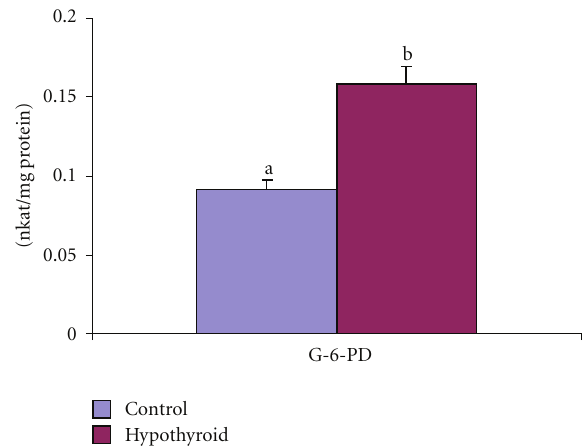
Figure 10: E ff ect of neonatal PTU treatment on Glucose-6- phosphate dehydrogenase activity (nkat/mg protein) in postmito- chondrial fraction (PMF) of testes of rats. Data are expressed as mean ± S.D. of 5 observations and subjected to unpaired Student’s t -test. Statistical significance was accepted at P < 0 . 05. Control and hypothyroid groups were found to di ff er significantly at P < 0 . 05 as represented by superscripts of di ff erent letters. Control (Group- I): 30-day-old control rats; hypothyroid (Group-II): 30-day-old rats with PTU treatment from day 1 postpartum to day 30